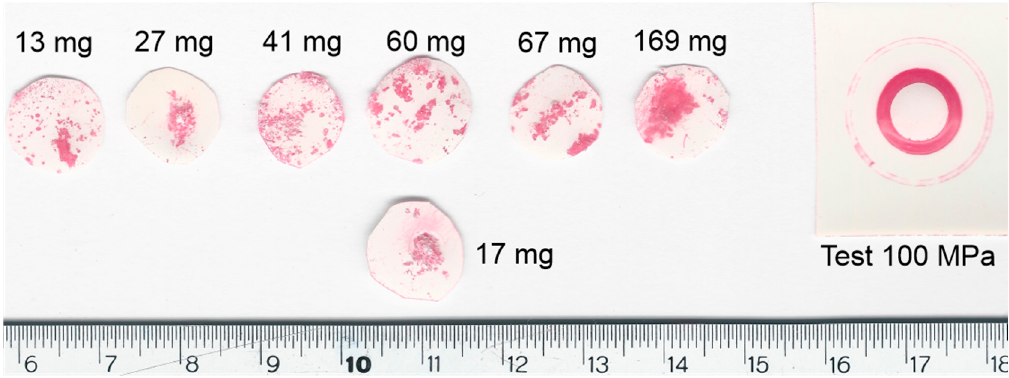
Figure 2. Images of the films impressed by several compressed crystals; on the right, a calibration test. The numbers represent the weight of samples in mg.